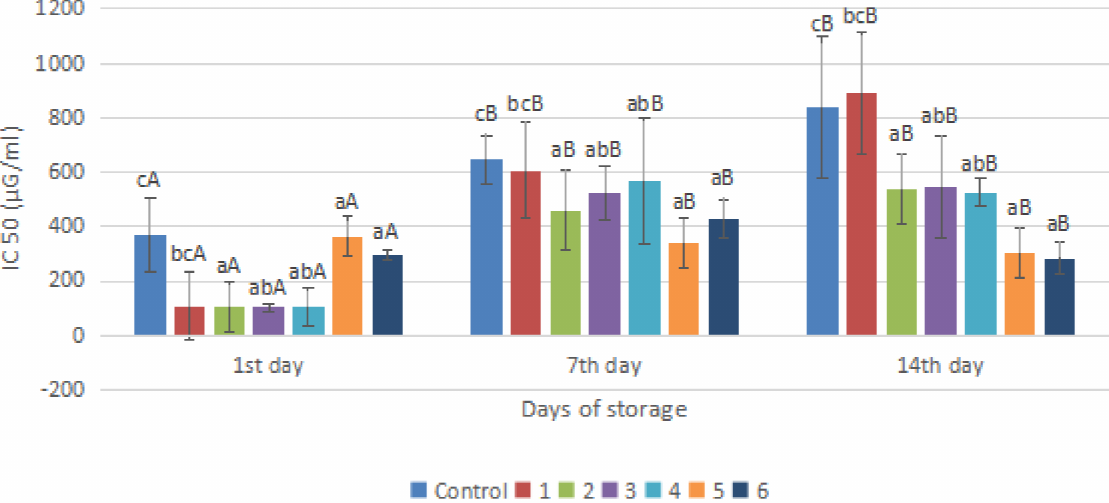
Figure 7. Total antioxidant of red chili during storage. a–c non-capital letters show the difference between the day of storage ( p < 0.05). A, B capital letters show the difference between the day of storage ( p < 0.05). Control: Uncoated Sample; 1: Gelatin75%-Pectin25%-Garlic Essential Oil2%; 2: Gelatin75%-Pectin25%-Garlic Essential Oil Oil3%; 3: Gelatin50%-Pectin50%-Garlic Essential Oil Oil2%; 4: Gelatin50%-Pectin50%-Garlic Essential Oil Oil3%; 5: Gelatin25%-Pectin75%-Garlic Essential Oil Oil2%; 6: Gelatin25%-Pectin75%-Garlic Essential Oil